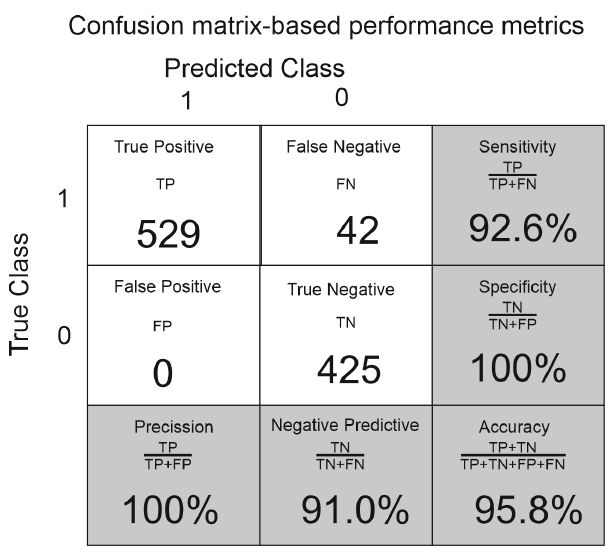
Figure 7. Confusion matrix and performance metrics of the validation data set. The subsidence area is labeled is “1”, while “0” describes areas without